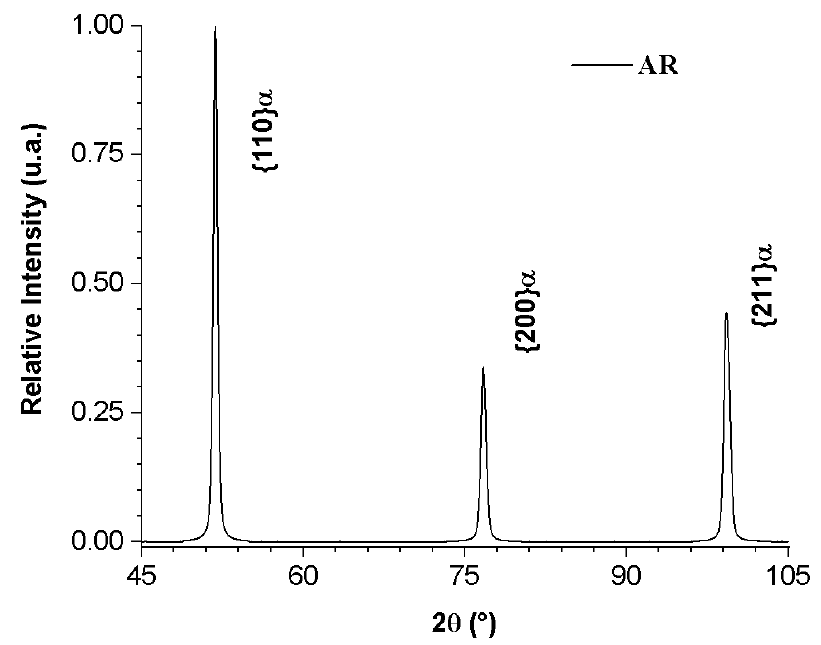
Table 1. Quantitative analysis of the microstructures: average particle diameter (PD), average lamel- lae thickness (LT) and preferred deviation in relation to RD (Dev.).